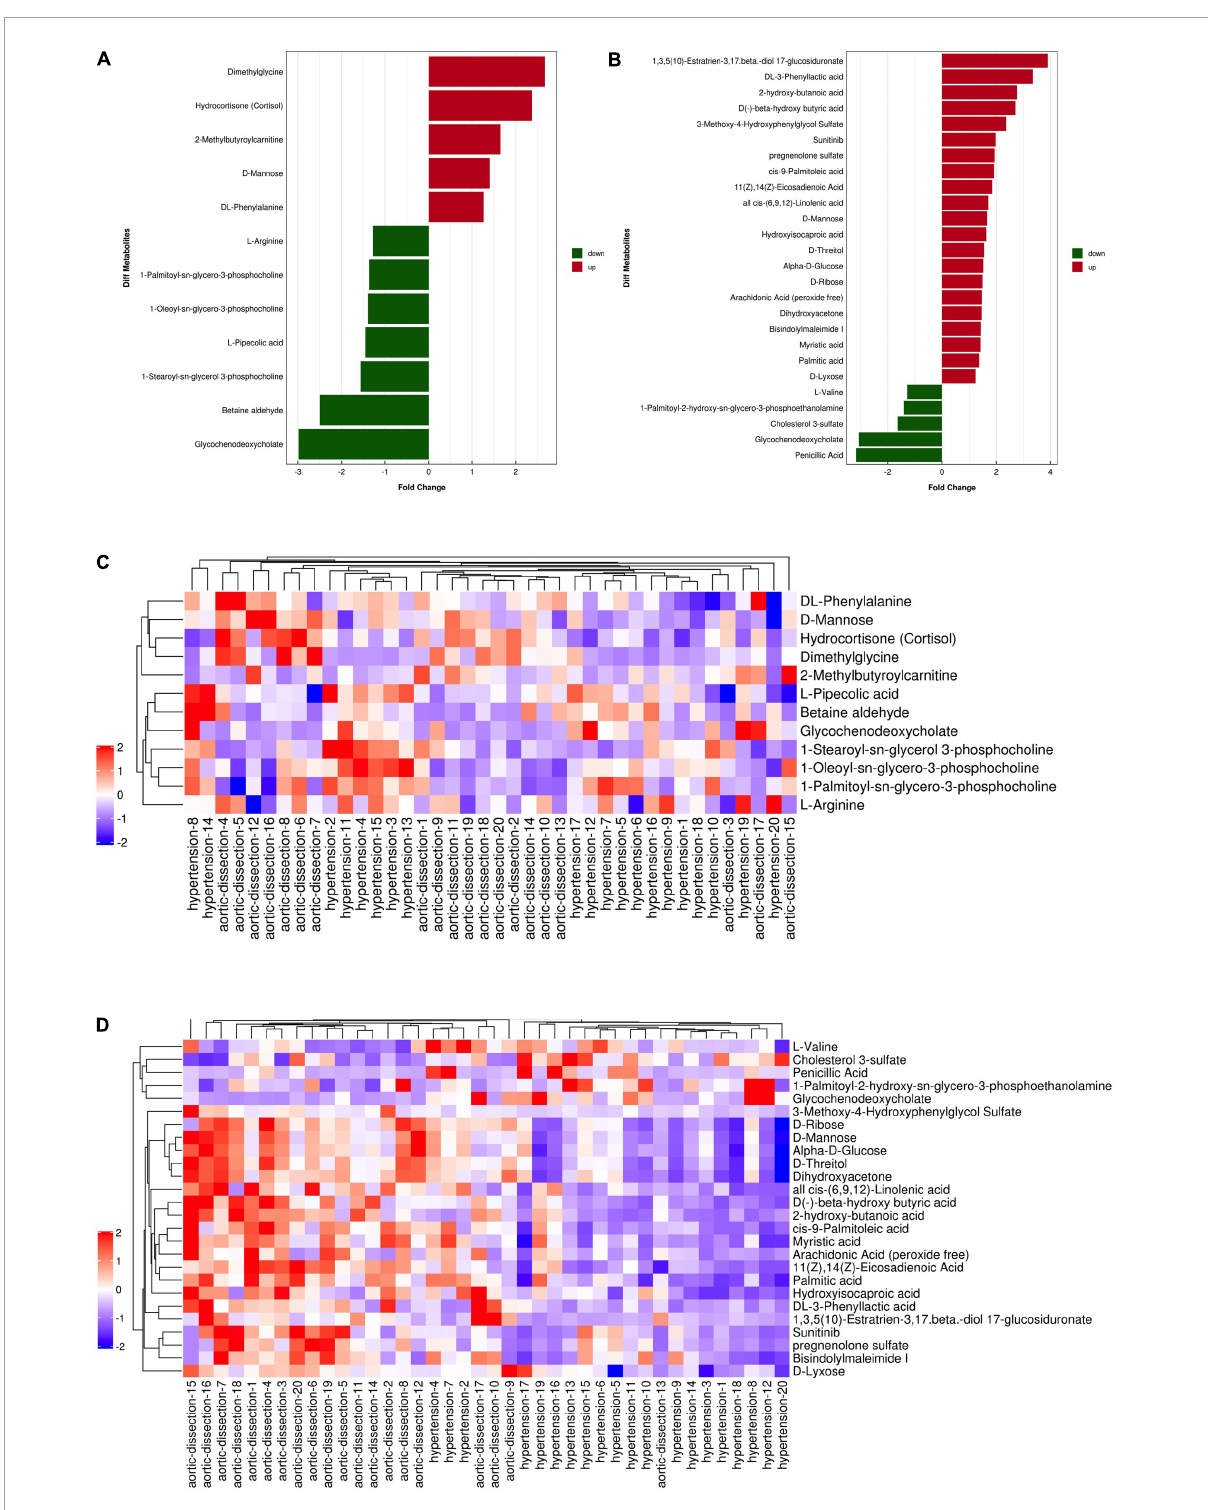
FIGURE2 Fold change analysis and heat map of the differential metabolites between hypertension and AAD groups in ESI positive and negative mode. (A) Fold change of five up-regulated metabolites (red bars) and seven down-regulated metabolites (green bars) in ESI positive ion mode. (B) Fold change of 21 up-regulated metabolites (red bars) and five down-regulated metabolites (green bars) in ESI negative mode. Heat map of the differential metabolites between hypertension and AAD groups in ESI positive (C) and negative (D) ion mode (red represents the metabolites in high abundance, blue represents the metabolites in low